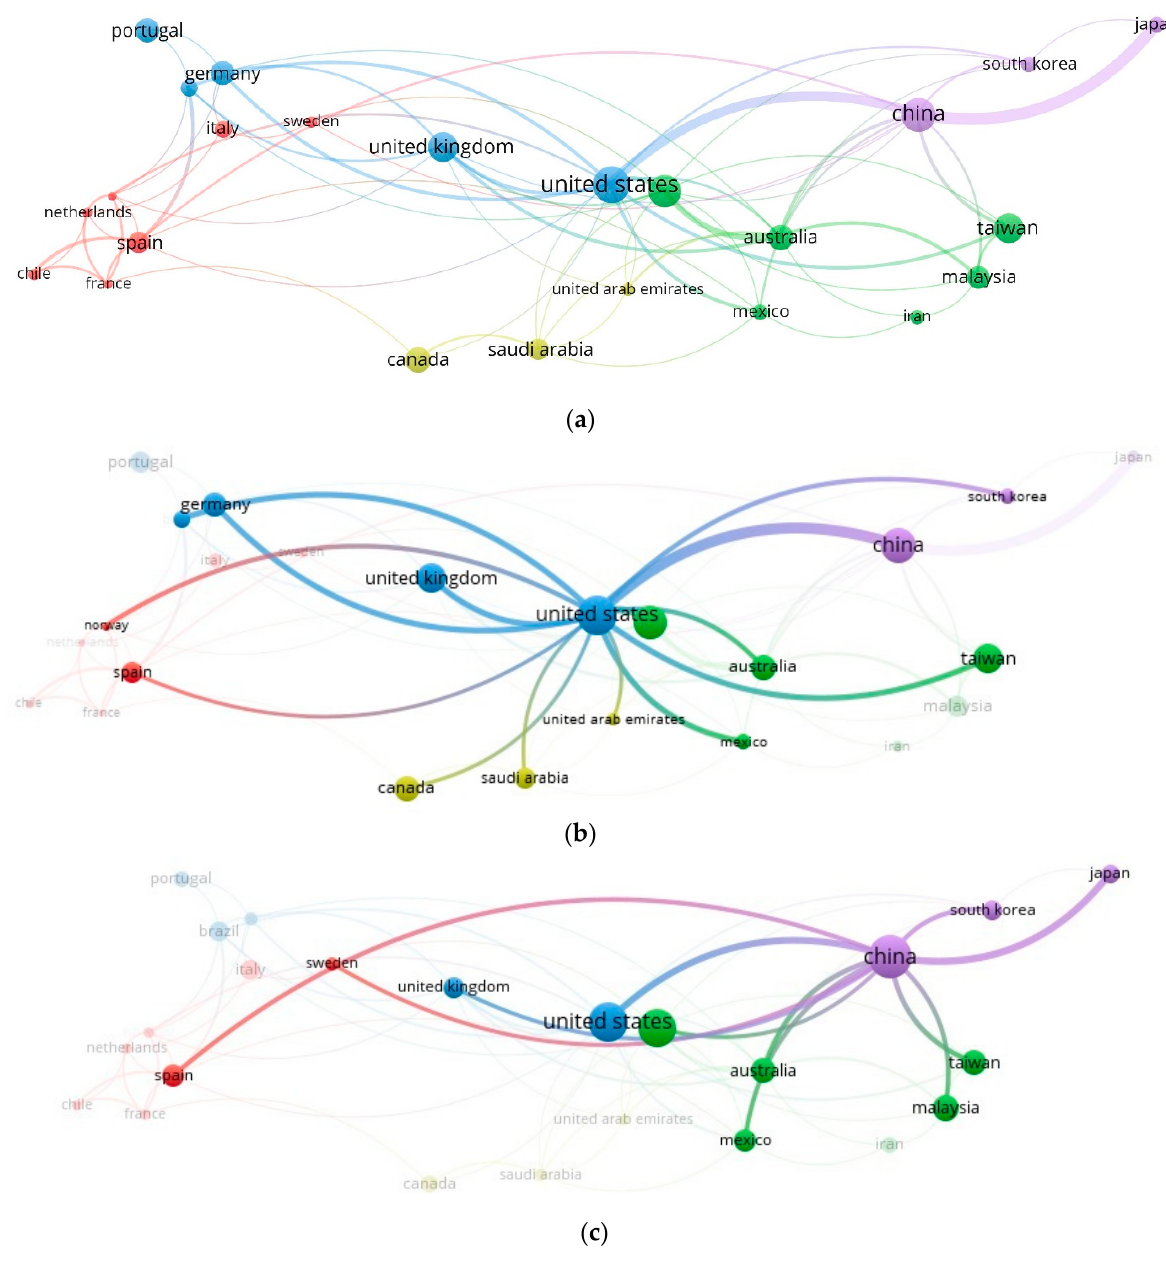
Figure 4. Collaboration maps of countries in publications on CO 2 capture with microalgae: ( a ) general collaboration network; ( b ) United States collaboration network; ( c ) China collaboration network. Five groups of countries: red, green, purple, yellow, and blue.